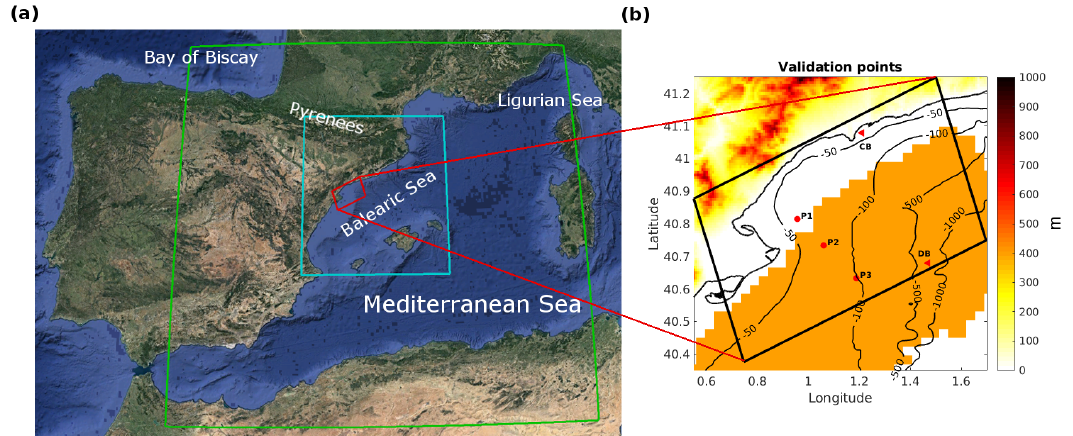
Figure 1. Study area. (a) NW Mediterranean Sea and numerical domains: 15km resolution domain for the SWAN model (green), 3km resolution domain for the SWAN model (blue) and 350m resolution coastal domain for the ROMS and SWAN models (red). (b) Orography (in meters), coastal domain, buoy locations (red triangles; CB and DB), points where the numerical results are examined in detail (red dots: P1, P2 and P3) and high-frequency (HF) radar coverage area (in orange).